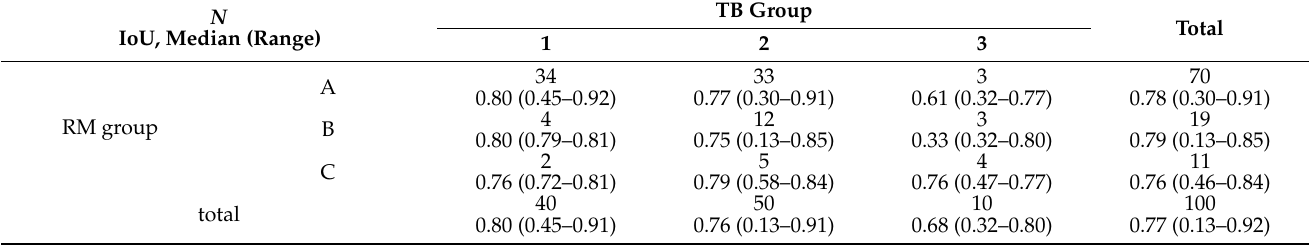
Table 3. The number of cases and Intersection over Unit for each class and overall.